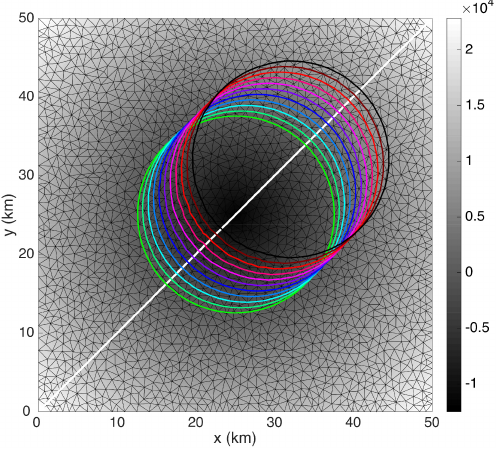
Figure A1. Zero-level-set positions at the start of every year, plot- ted over ϕ 0 , which is in grey scale. An example of the mesh with element size 1km is marked in black. The white diagonal marks the line along which the velocity of the 0 level set is tracked.